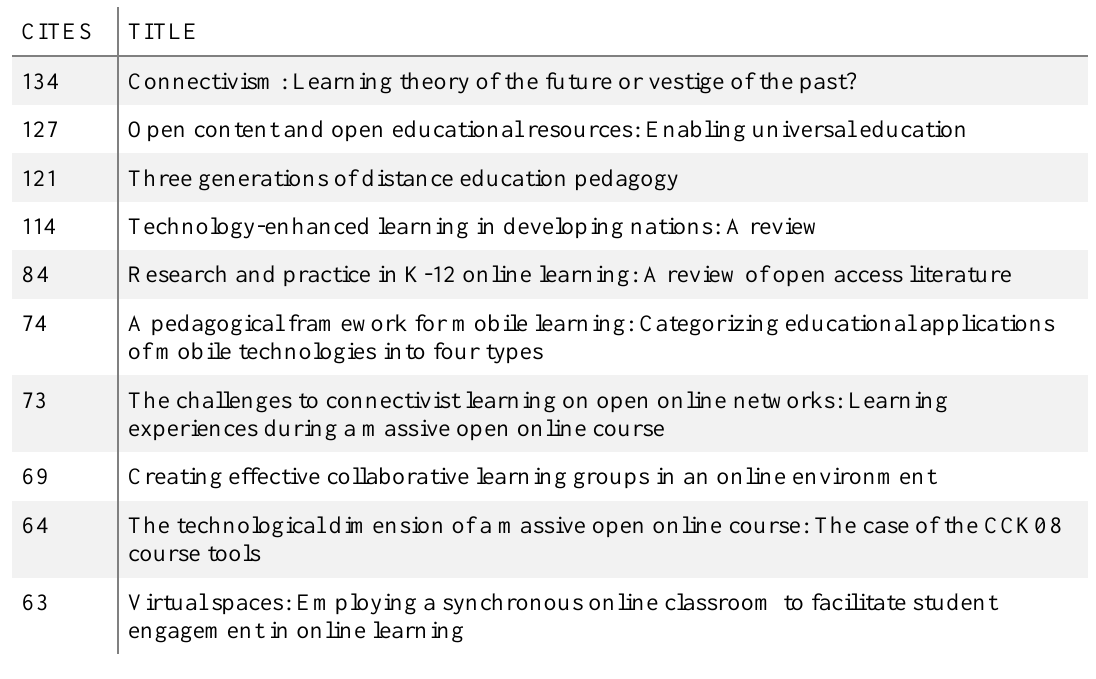
Ten Articles with Most Citations